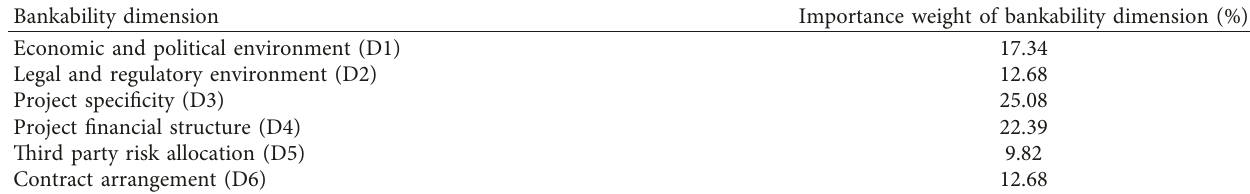
Table 3: Relative importance weights of bankability dimensions from the banks’ perspective.